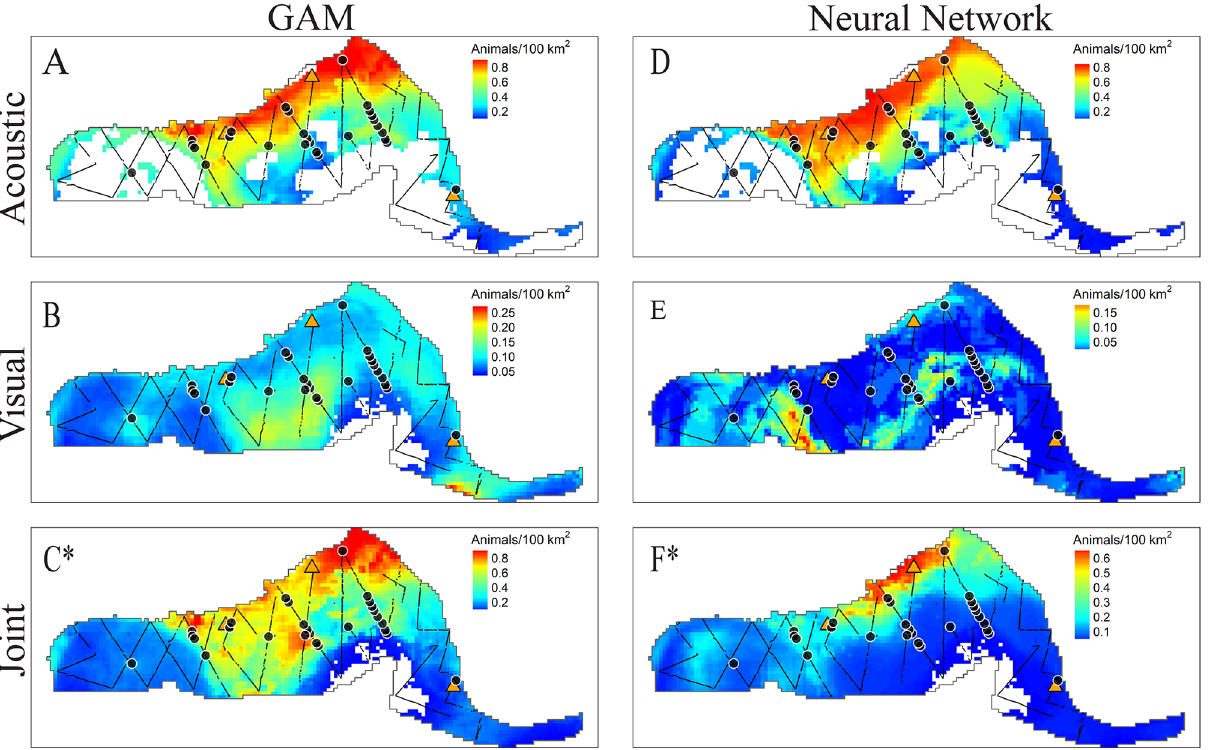
Figure 8. Predicted sperm whale densities (colormap) across the model area for July 2009 from density-based GAMs (subplots A-C) and NNs (D-F). Annotations as in Fig. 5. The best fitting model based on RMSE was the joint neural network. Maps created using tmap 45 .